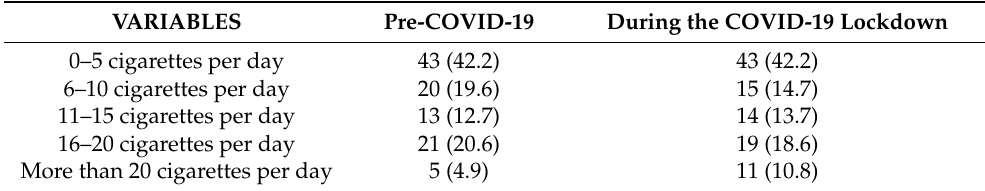
Table 6. Results for the changes in the patient smoking habits during the COVID-19 pan- demic